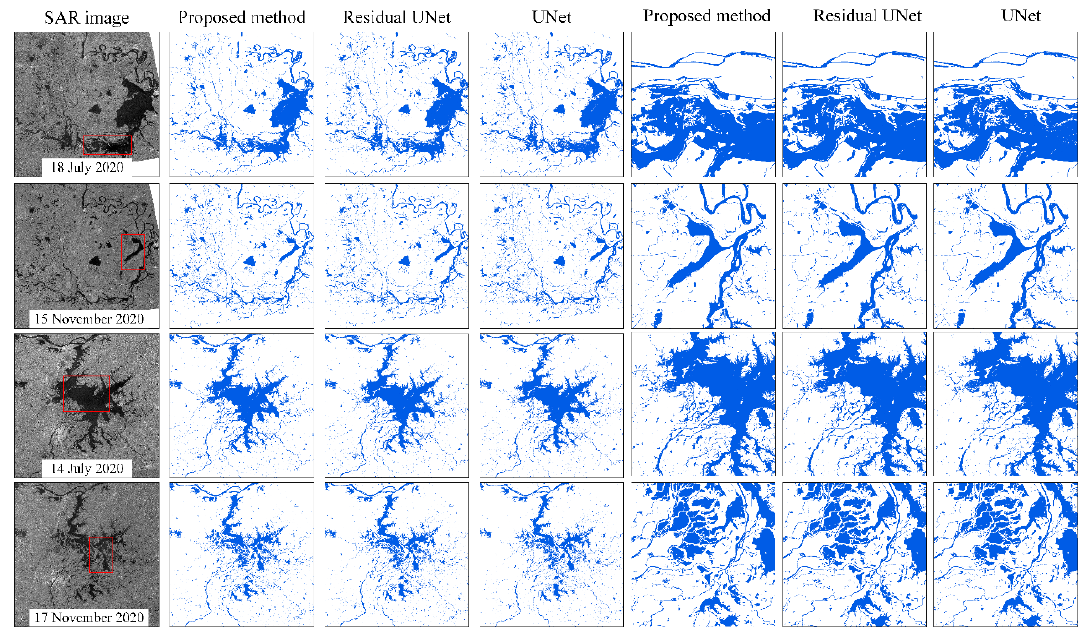
Figure 9. Comparison of different methods. The last three columns correspond to the enlarged image in the red box. Table 3. Comparison results of accuracy evaluation. Acquisition